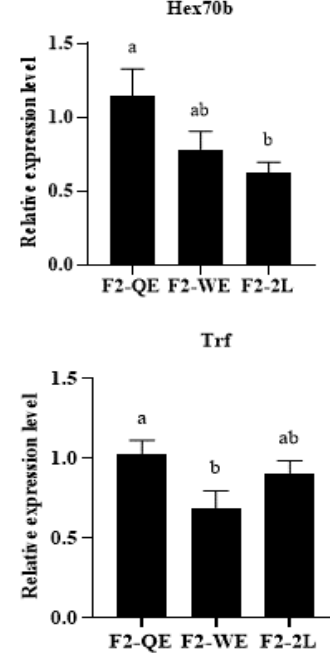
Figure 3. The expression level of development-related genes of reared F2 queens.Different letters above the bars indicate significant differences between groups ( p < 0.05, one-way ANOVA test followed with Fisher’s LSD